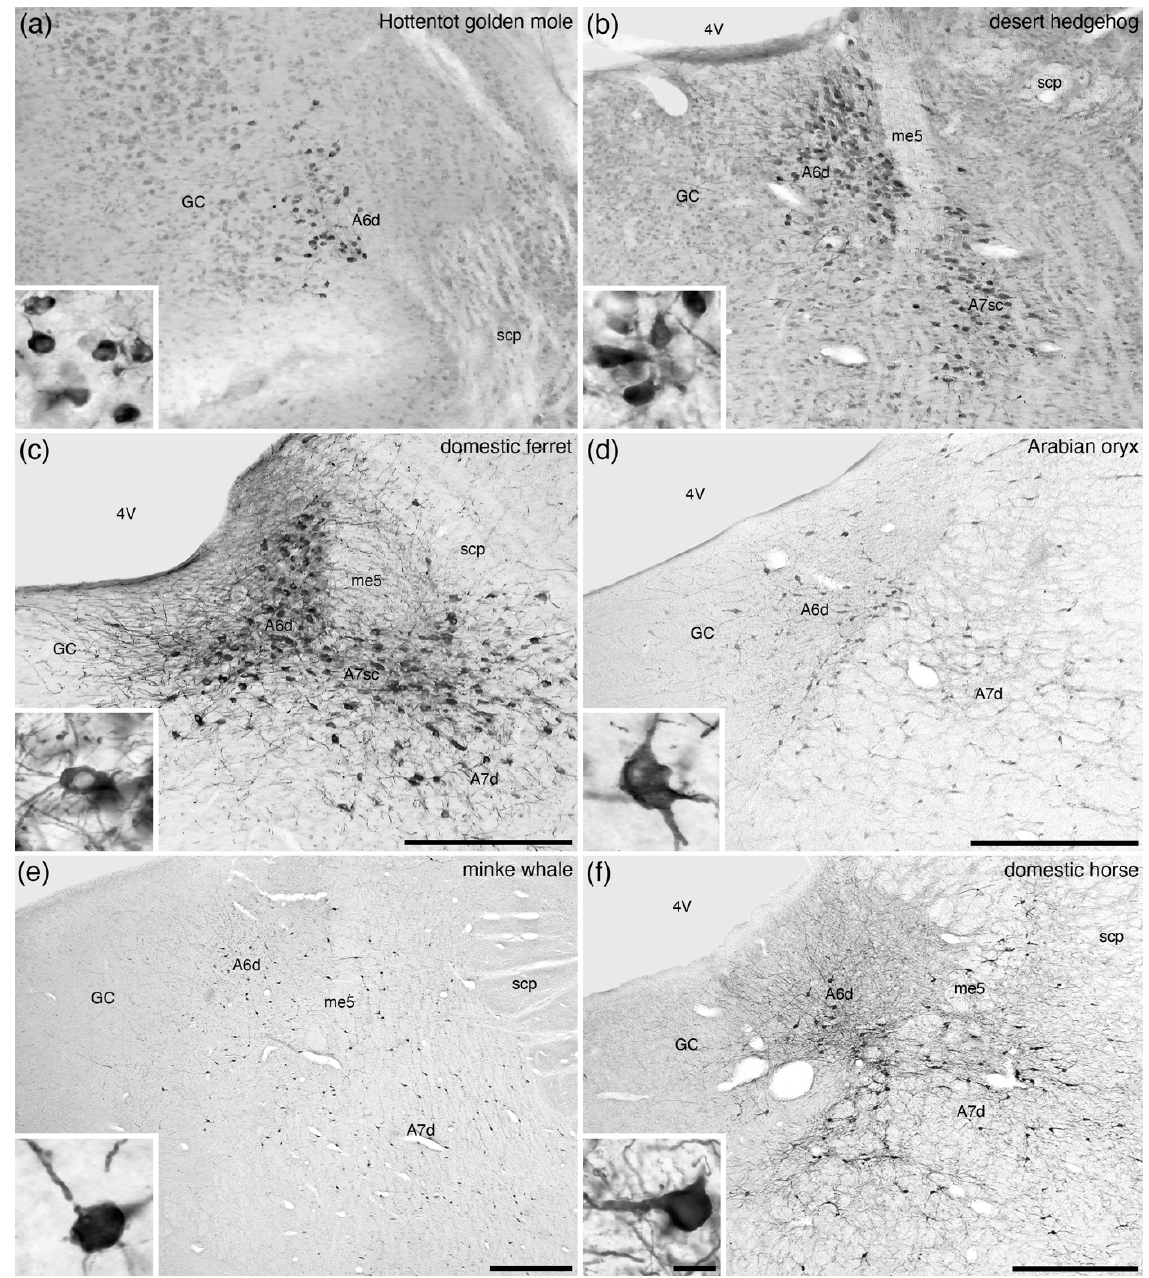
Figure 3. Low-magnification photomicrographs of the locus coeruleus ( A6 ), revealed with tyrosine hydroxylase immunostaining, in the brains of one species of Afrotheria, ( a ) the Hottentot golden mole ( Amblysomus hottentotus ) [16], and five species of Laurasiatheria, including ( b ) the desert hedgehog ( Paraechinus aethiopicus ) [19], ( c ) the domestic ferret ( Mustela putorius ) [27], ( d ) the Arabian oryx ( Oryx leucoryx ) [31], ( e ) the minke whale ( Balaenoptera acutorostrata ) [36], and ( f ) the domestic horse ( Equus caballus ) [pers. obs.]. Note how the density of neurons in the locus coeruleus of all these species show the diffuse-type of organization ( A6d ) typical of mammals (Table 1). In all images, dorsal is to the top and medial to the left. Scale bar in ( c ) = 500 µm and applies to ( a – c ). Scale bars in ( d – f ) = 1 mm and applies to the respective images. Scale bar in inset ( f ) = 25 µm and applies to all insets. 4V —fourth ventricle; GC —periventricular grey matter of the rostral hindbrain; me5 –fifth mesencephalic tract; scp —superior cerebellar peduncle.